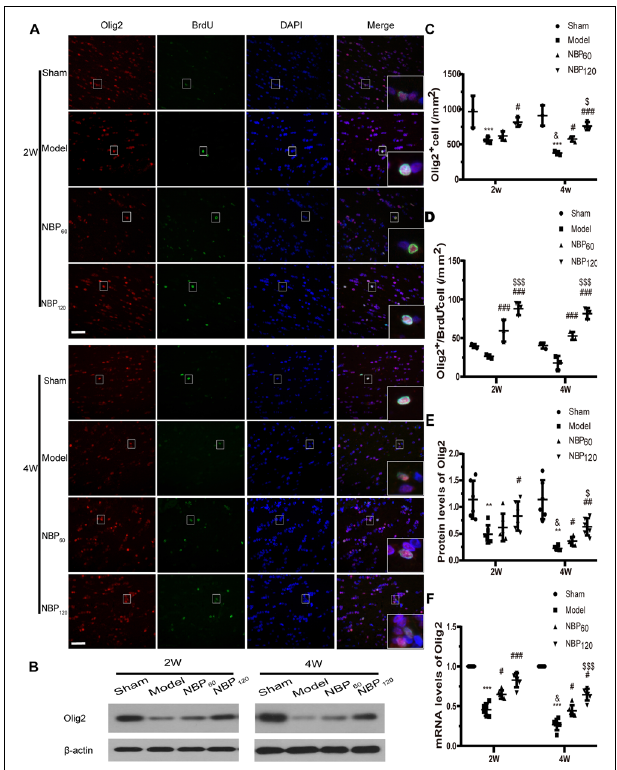
FIGURE 4 | Dl-3-n-butylphthalide (NBP) promotes oligodendrocytes regeneration in corpus callosum after 2VO. (A) Representative images of Olig2 (red) and BrdU (green) immunofluorescence double labeling in corpus callosum at 2 weeks and 4 weeks after 2VO. Bar = 50 µ m. Typical double-labeled areas are magnified ( n = 3 in each group). (B) Western blot analysis of the expressions of Olig2 ( n = 6 in each group). (C) The number of Olig2+ cells in corpus callosum. (D) The number of Olig2+/BrdU+ cells in corpus callosum. (E) Quantitative analysis of protein levels of Olig2. β -actin was used as an internal control. (F) Quantitative analysis of mRNA levels of Olig2. β -actin was used as an internal control ( n = 6 in each group). ** p < 0.01, *** p < 0.001, the model group vs. the sham group; # p < 0.05, ## p < 0.01, ### p < 0.001, the NBP60 group or NBP120 group vs. the model group; $ p < 0.05, $$$ p < 0.001, the NBP60 group vs. NBP120 group; and & p < 0.05, the model group sacrificed at 2 weeks vs. the model group sacrificed at 4 weeks. Values are expressed as mean ± SD. Olig2, oligodendrocyte lineage transcription factor